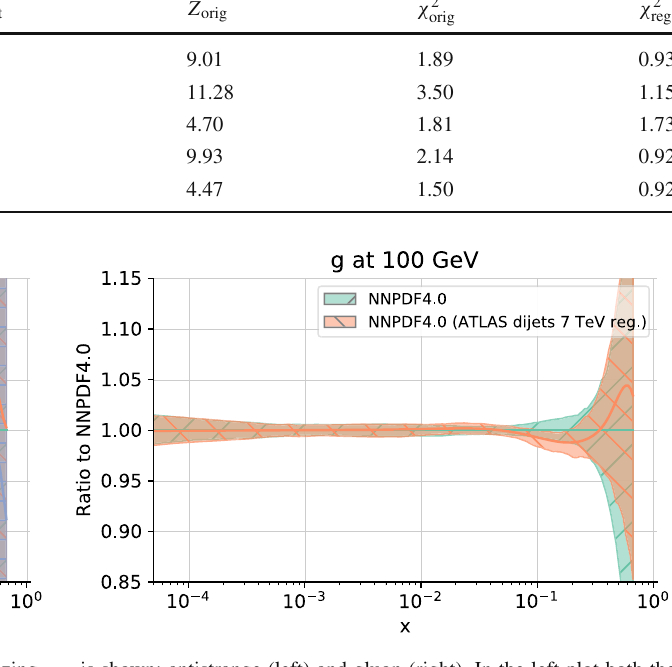
is shown: antistrange (left) and gluon (right). In the left plot both the default baseline and a baseline with the unregularized data are